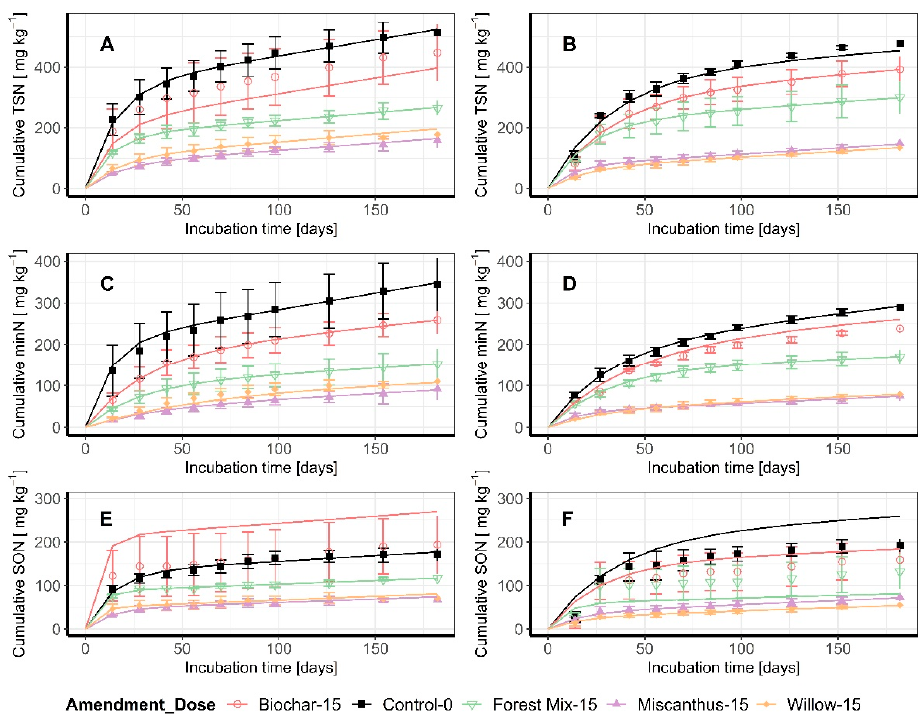
Figure 2. Cumulative TSN and minN and their fitting curves. The curves were computed only on measured values (TSN and minN). ( A ) TSN for the Haplosaprist; ( B ) TSN for the Haplohemist; ( C ) MinN for the Haplosaprist; ( D ) MinN for the Haplohemist; ( E ) SON for the Haplosaprist; ( F ) SON for the Haplohemist.